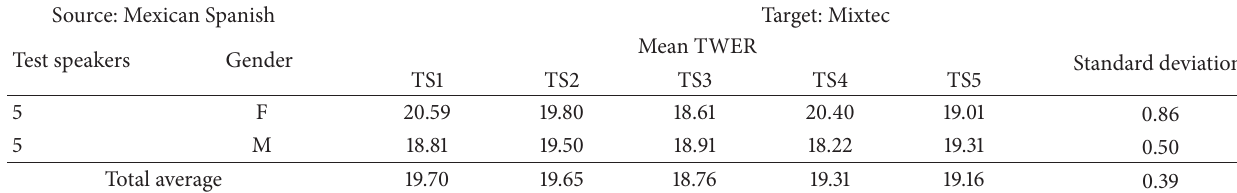
Table 6: TWER of the Spanish-to-Mixtec